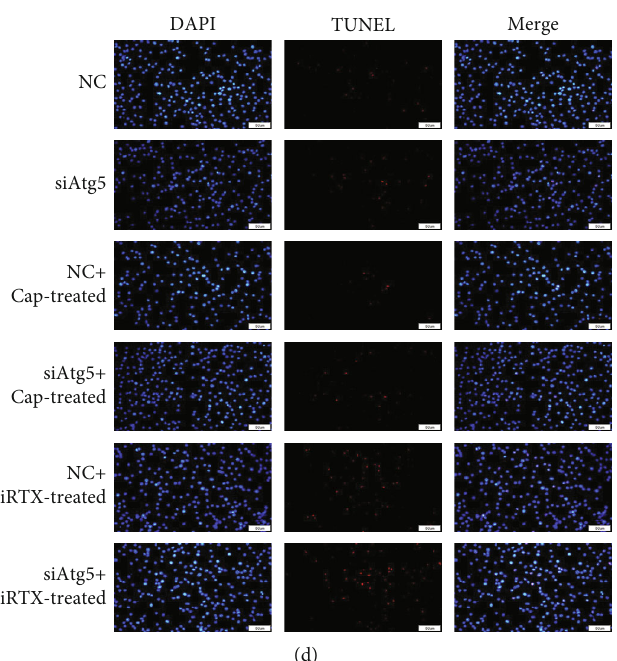
Figure 4: TRPV1 and apoptosis, Atg5-mediated autophagy in OGD/R microglia. Apoptosis was assayed in OGD/R microglia, and an autophagy-related protein of siRNA-Atg5 (siAtg5) along with negative (NC) siRNA-transfected cells, TRPV1 agonist Cap, and TRPV1 inhibitor iRTX was involved. (a, b) JC-1 was assayed by fl ow cytometry and analyzed. (c) The level of caspase 3 was measured using the ELISA kit. (d) Apoptosis was assayed using TUNEL staining. The data was given as mean ± SD , n = 3 . ∗ p < 0 : 05 and ∗∗ p < 0 : 01 compared with microglia in culture (control). # p < 0 : 05 compared with microglia on glucose depreciation/reoxygenation (OGD/R) culture condition